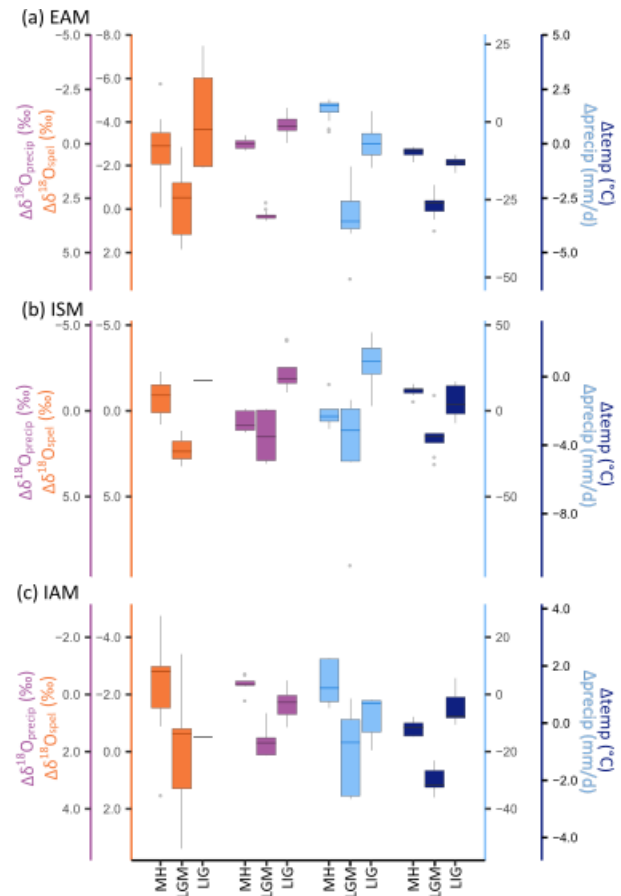
Figure 3. Speleothem δ 18 O anomalies compared to anomalies of δ 18 O precip , precipitation and temperature from the ECHAM sim- ulations for the (a) East Asian (EAM), (b) Indian (ISM) and (c) Indonesian–Australian (IAM) monsoons. The boxes show the median value (line) and the interquartile range, and the whiskers show the minimum and maximum values, with outliers represented by grey dots. Note that the isotope axes are reversed, so that the most negative anomalies are at the top of the plot, to be consistent with the assumed relationship with the direction of change in pre- cipitation and